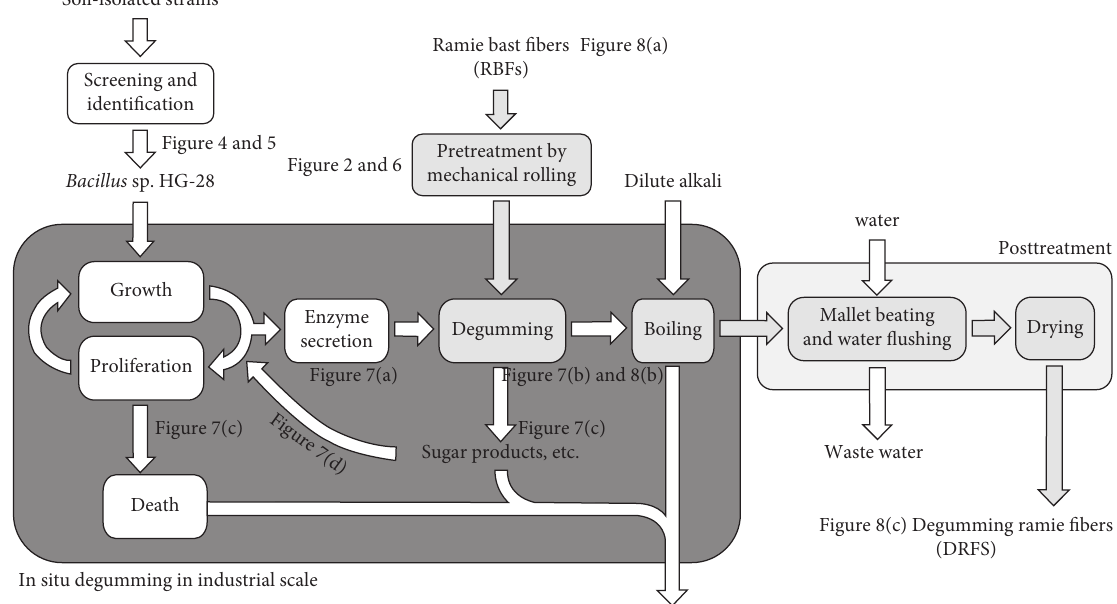
Figure 14: Detailed retting schematic for in situ microbial retting process [144].